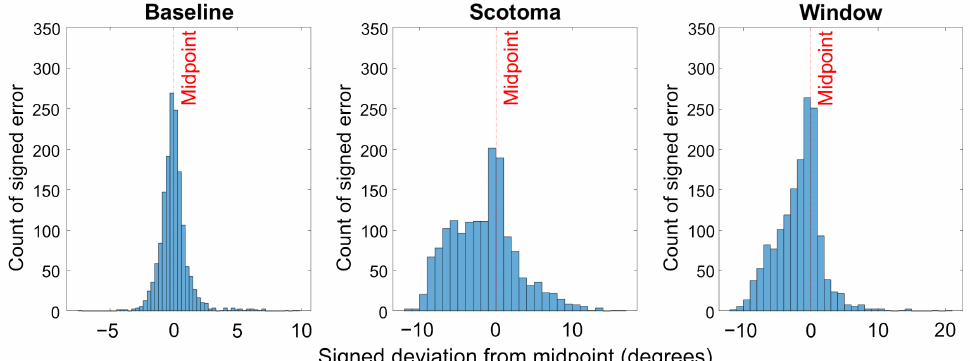
Figure 6. Histogram illustrating the response counts across all participants, collapsed across line lengths. Accuracy and precision improves in the window condition (by becoming more normally distributed compared to the Scotoma